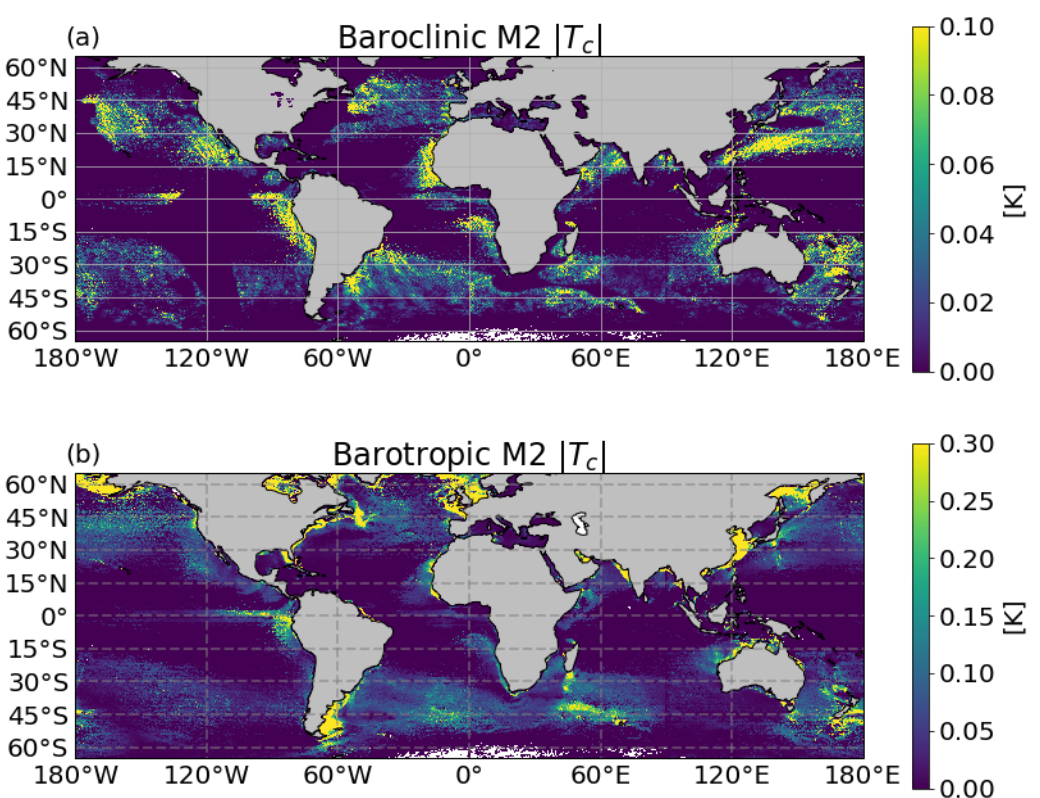
Figure 5. ( a ) Estimation of the amplitude of M2 IW signature on SST. ( b ) Estimation of the amplitude of M2 barotropic signature on